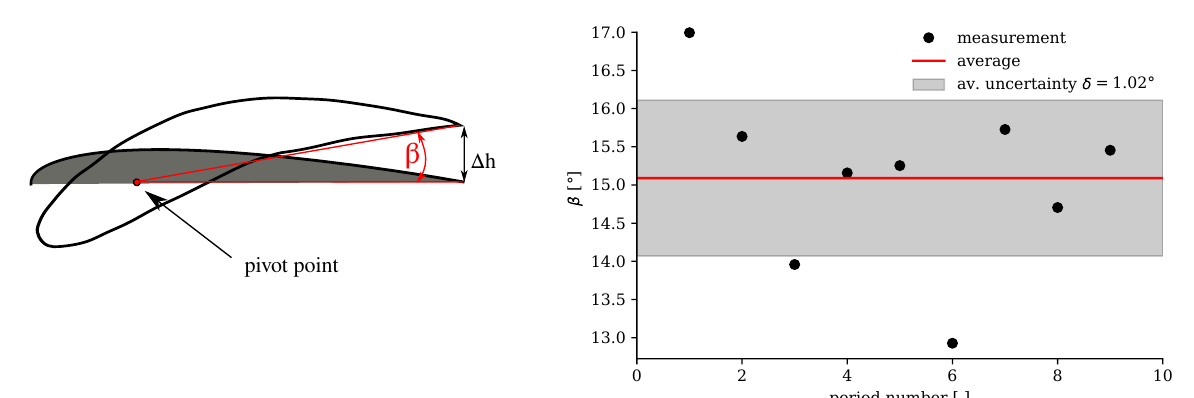
Figure 10. Definition of β . The profile tip was not considered to suppress errors from tip recognition uncertainty in the cross-section detection algorithm. Flexible profile deformation for multiple periods, expressed with the deformed angle of incidence β ( α = 28°, k =